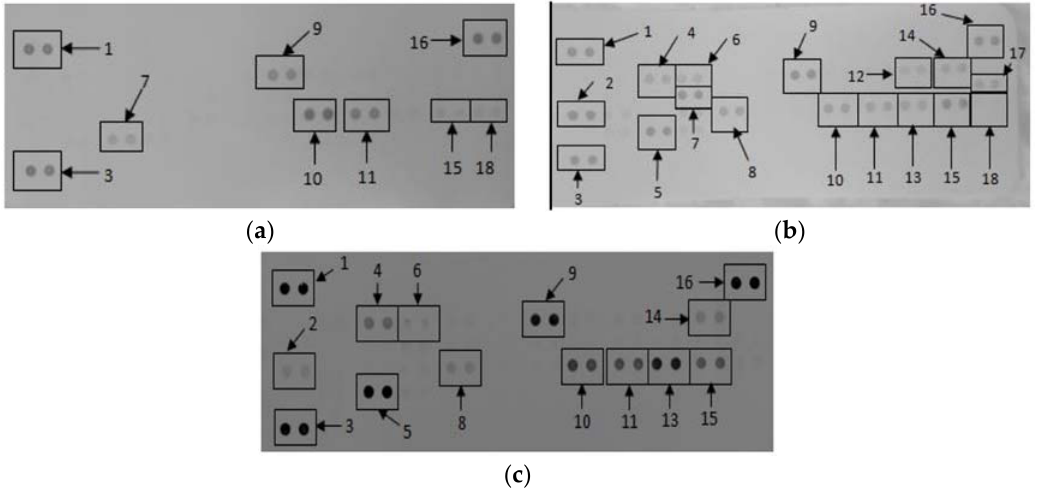
Figure 3. The effect of CDs on RAW 264.7 cells. Cells were incubated with ( a ) media only (negative control); ( b ) media in the presence of LPS and ( c ) 500 μ g/mL CDs in the absence of a mitogen. Supernatants were probed using the proteome profiler array as described in methods.